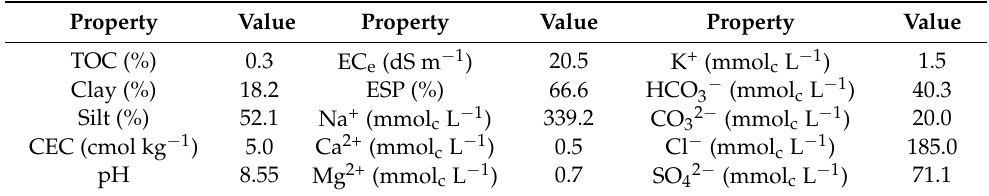
Table 1. Chemical and physical parameters of the saline-sodic soil, before reclamation. Property Value Property Value Property